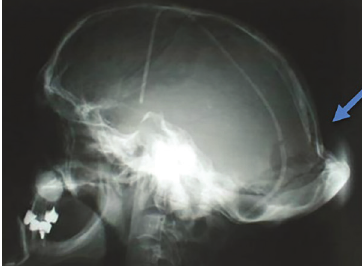
Figure 8 - Appearance of a patient with Hajdu-Cheney syndrome (hypertelorism, bushy eyebrows, micrognathia, low set ears and short neck present)